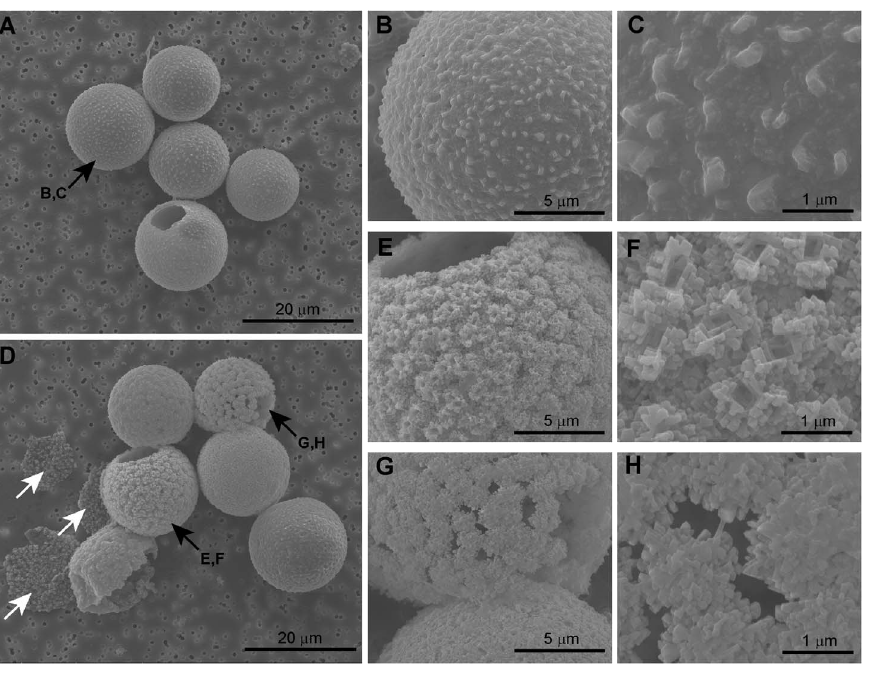
Figure 2. Effect of elevated p CO 2 on cyst morphology. Cells grown under (A–C) 150 m atm CO 2 and (D–H) 1400 m atm CO 2 . Black arrows indicate cysts that are shown in detailed images, white arrows show collapsed cysts.